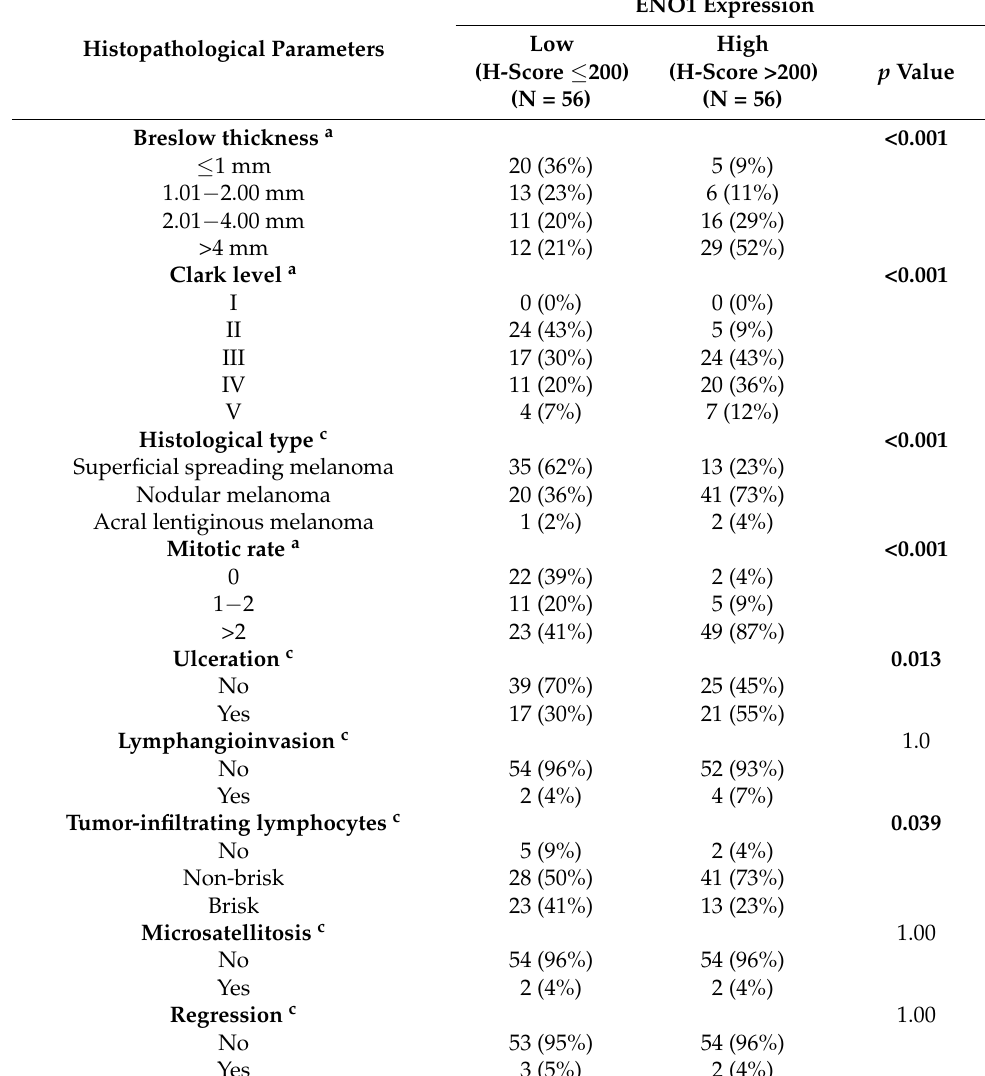
Table 2. Correlations between ENO1 expression and histopathological parameters in primary tumors of cutaneous melanoma